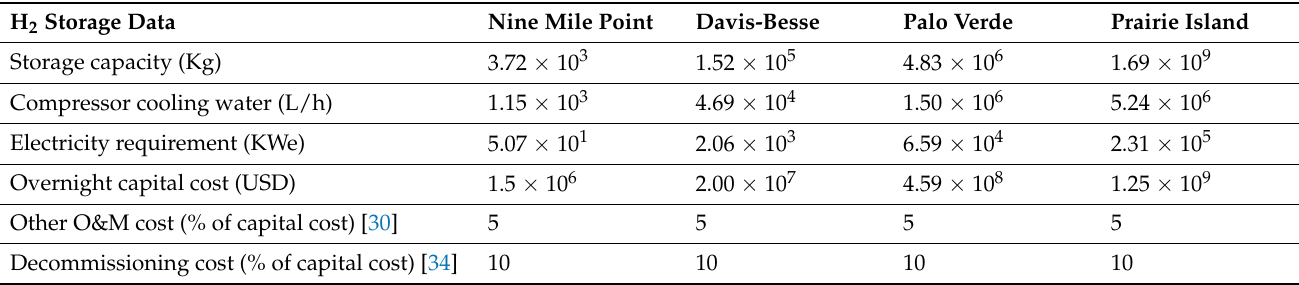
Table 4. Input data for hydrogen storage using the compressed gas method.